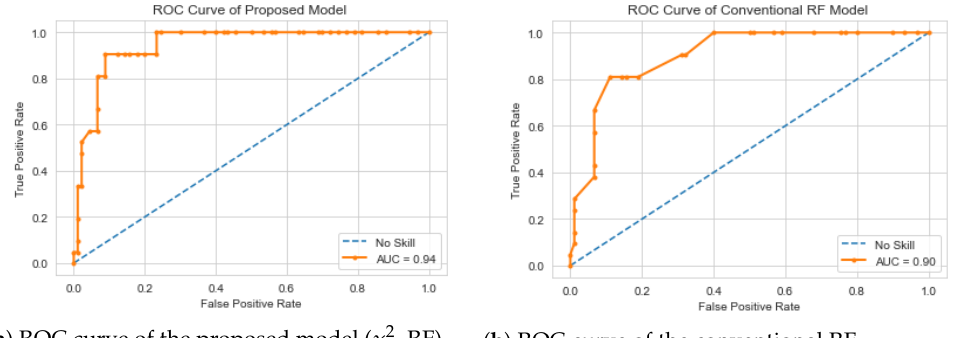
Figure 3. Performance comparison based on